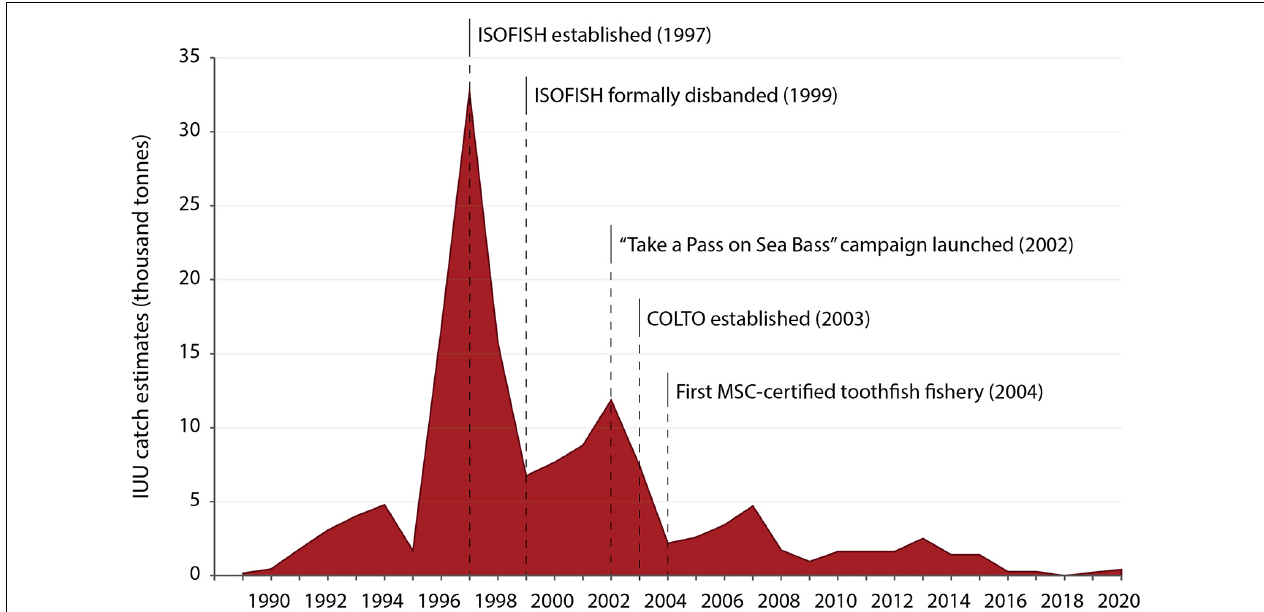
FIGURE 4 | IUU catch estimates for toothfish. Volumes of both Patagonian toothfish ( Dissostichus eleginoides ) and Antarctic toothfish ( Dissostichus mawsoni ) are aggregated. Data are from CCAMLR (until 2010) and COLTO (since 2011, based on market price and surveillance data). Key stages in the elimination of illegal catches are also